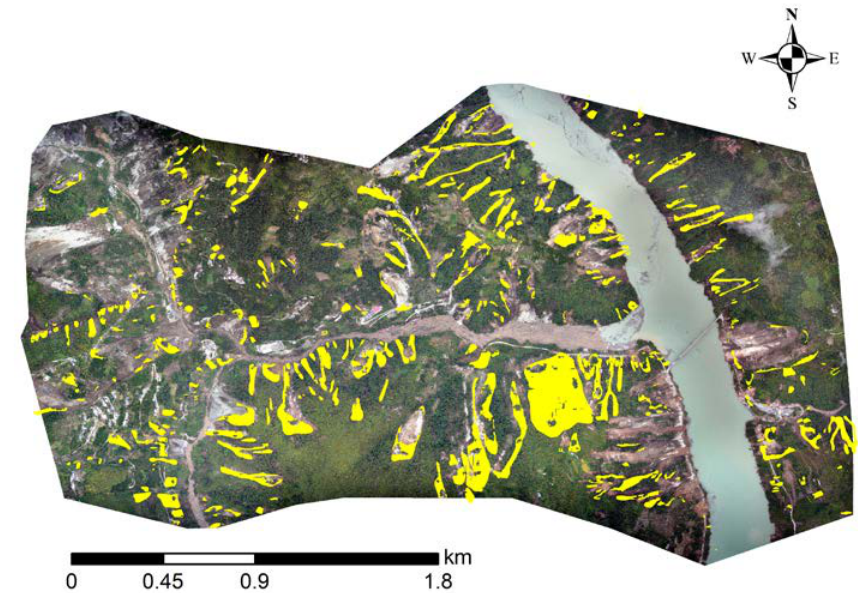
Figure 5. Undetected areas in GF-6 and Landsat 8 images.